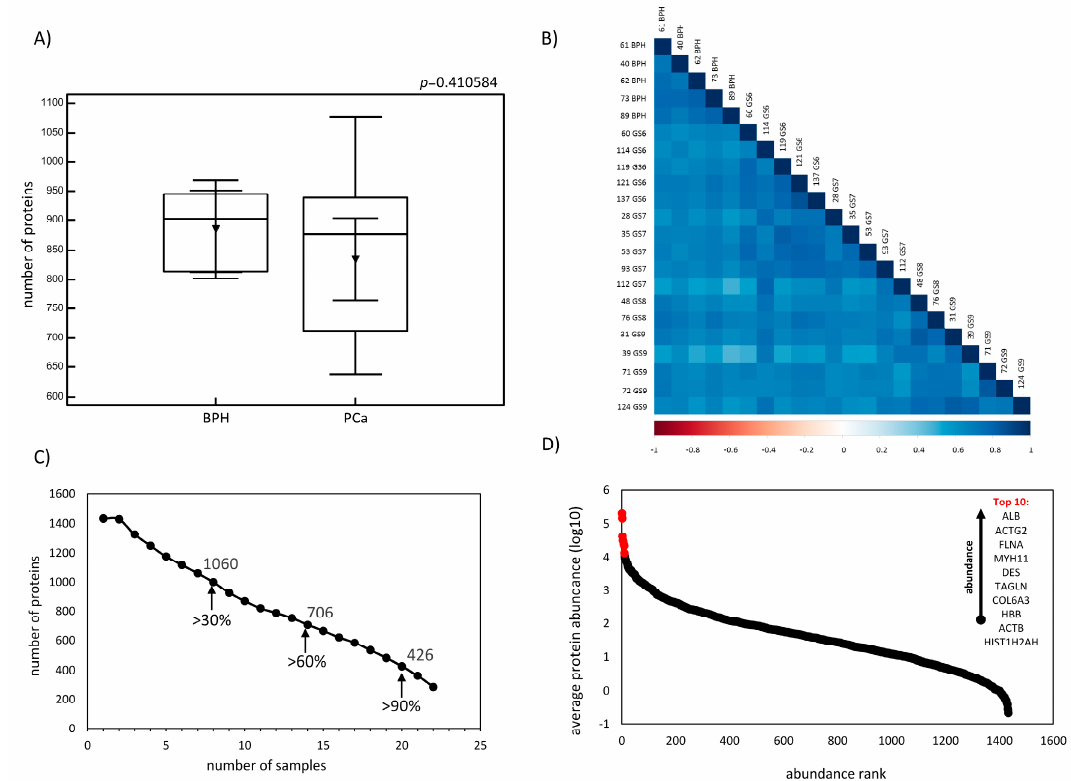
Figure 1. Tissue proteome characterization: ( A ) Boxplots representing the number of proteins identified in prostate tissue samples from patients with benign prostatic hyperplasia (BPH) and prostate cancer (PCa). ( B ) Graphical representation of the correlation matrix for normalized protein abundances across the individual samples: the Spearman Rho correlation coefficient is colour coded. All relationships were significant at p < 0.05. ( C ) The data completeness plot reflects representation of the number of proteins identified in the specific number of samples. The number of proteins identified in more than 30%, 60% and 90% of samples are indicated. ( D ) Graphical representation of protein rank against the average protein abundance (log10) calculated based on all analysed samples ( n = 22): Ten proteins with the highest abundance are highlighted in red. Abbreviations: ALB—serum